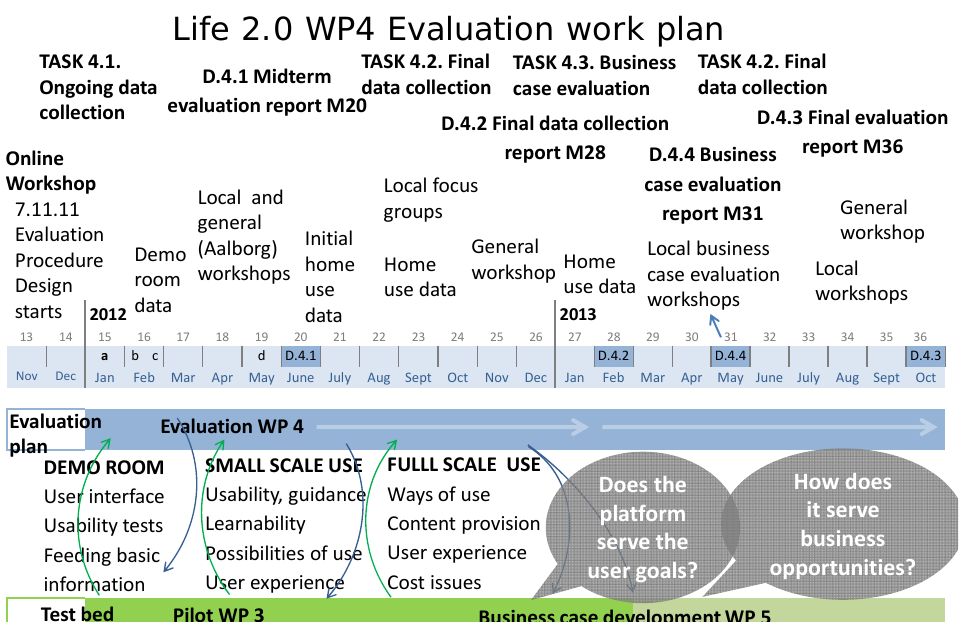
Figure 1. Life 2.0 pilot phase evaluation work